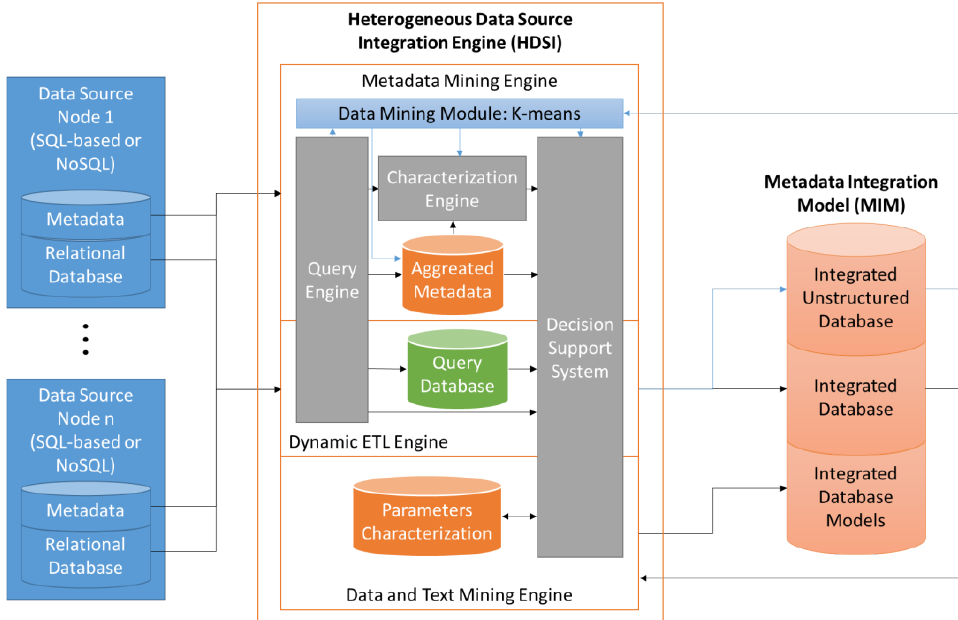
Figure 2. Overview of the internal architecture of HDSI and its connections with the data sources and the MIM.